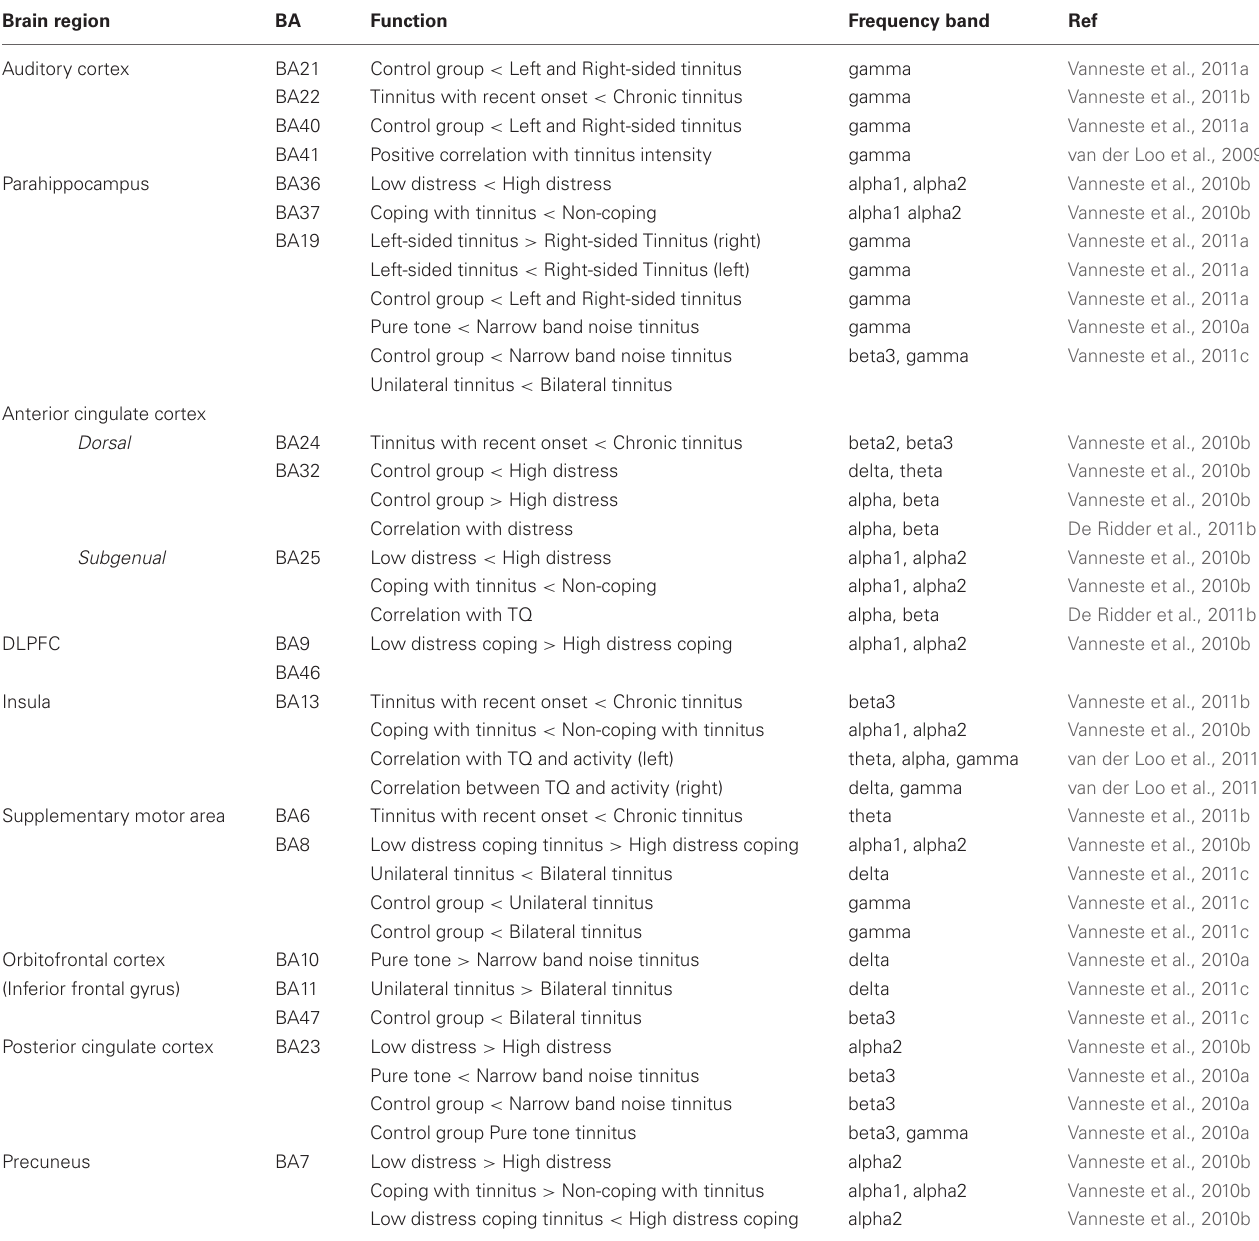
Table 1 | Overview results based on resting-state EEG in tinnitus